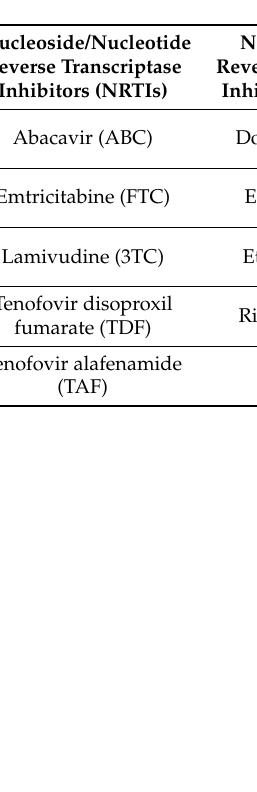
Table 2. Clinical trial evaluation of hepatic toxicity and incidence for non-nucleoside reverse transcriptase inhibitors.